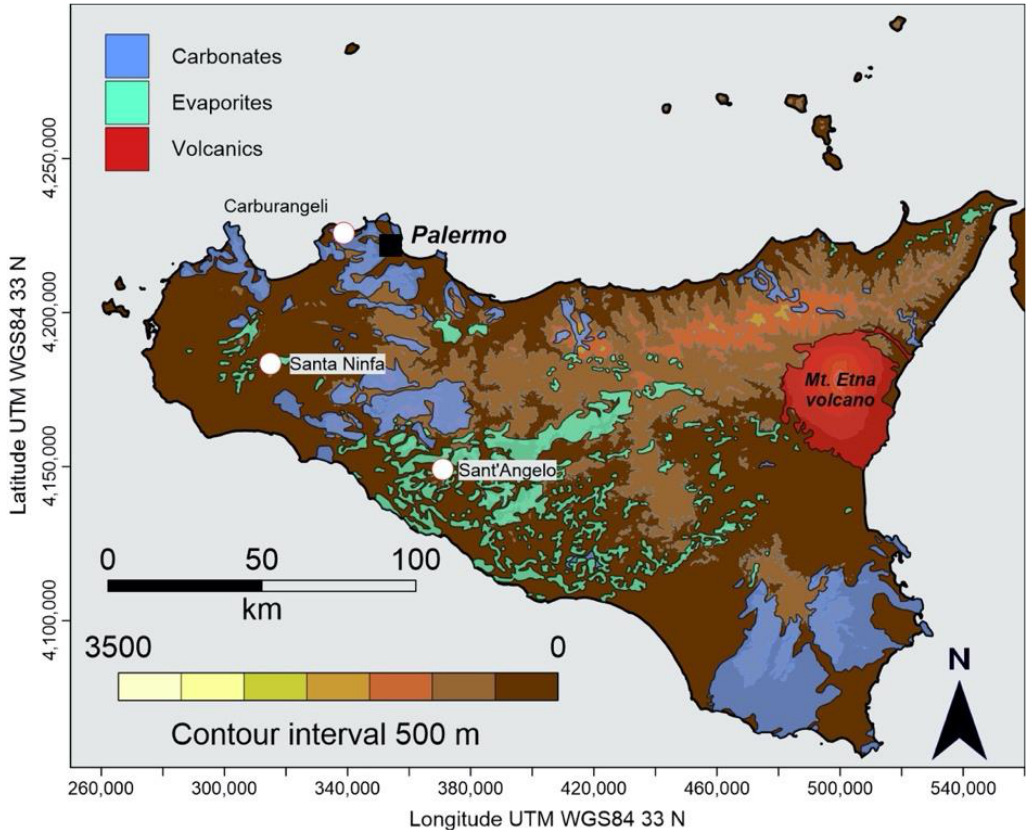
Figure 1. Distribution of karst areas in Sicily [13] and location of the studied caves.